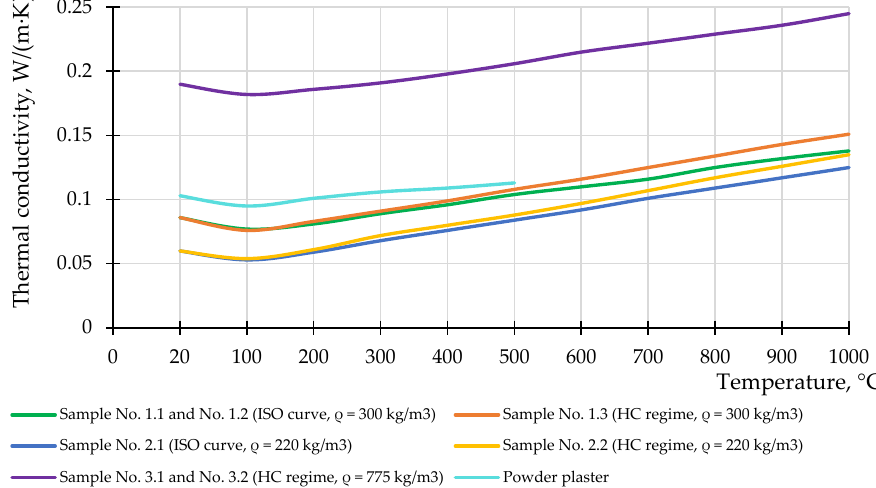
Figure 17. Calculated thermal conductivity coefficients of plaster compositions as a function of tem- perature.